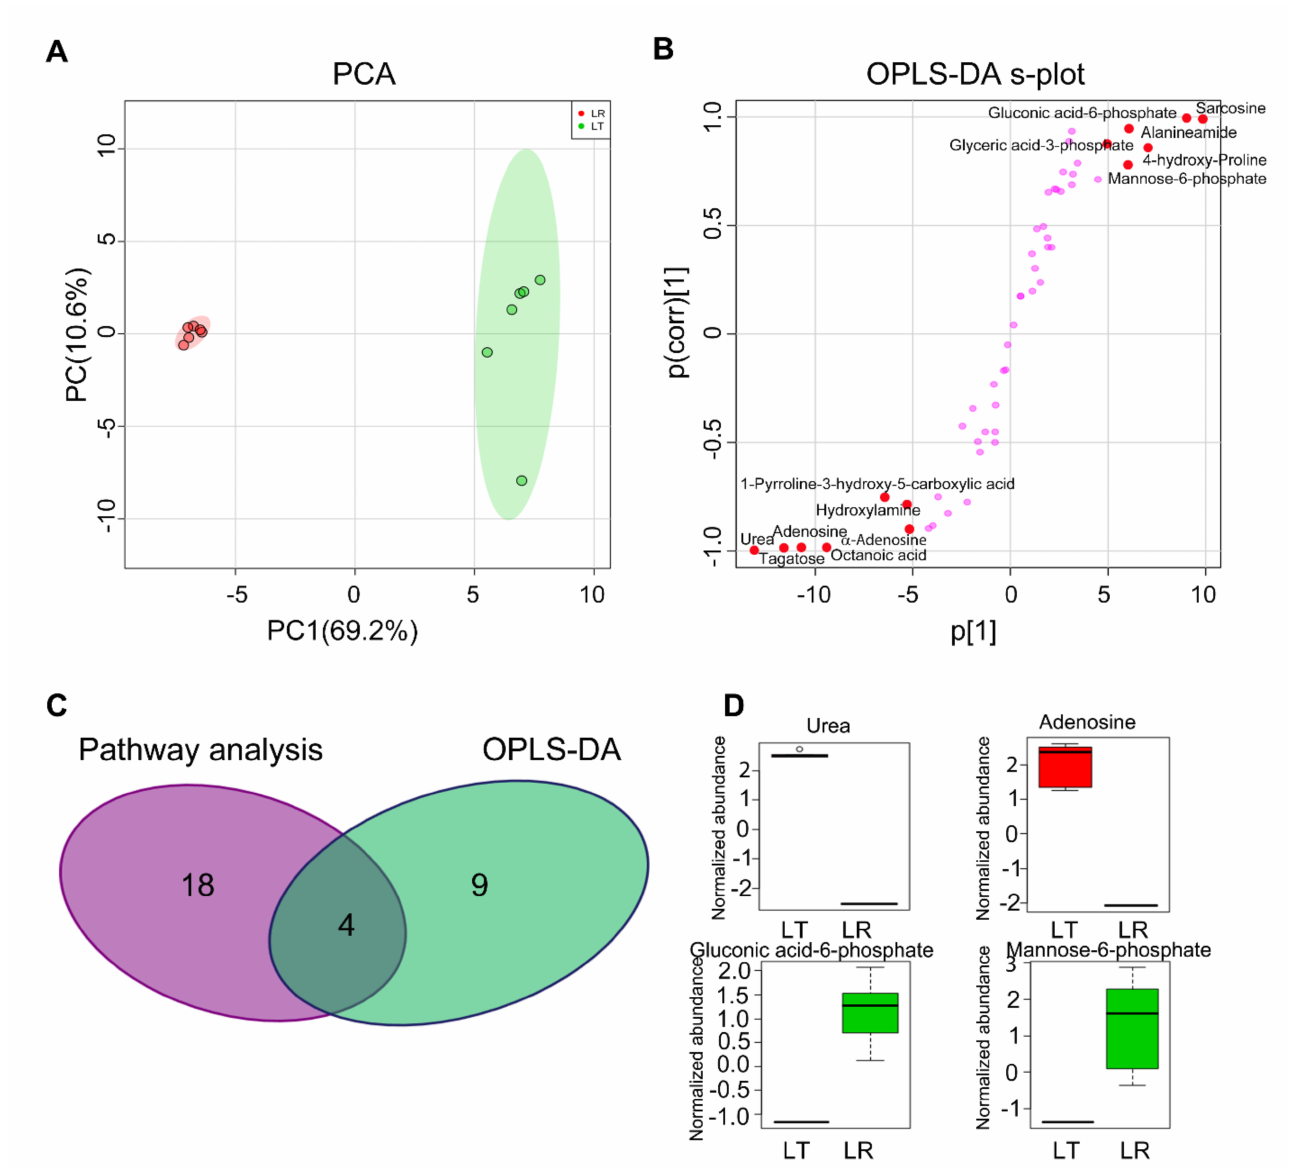
Figure 4. Identification of crucial metabolites. ( A ) PCA analysis of LT and LR groups according to the treatments set. Each dot represents a technological replicate analysis of samples in the plot. PC1 and PC2 used in this plot explain 79.8% of the total variance, which allows confident interpretation of the variation. PC1, principal component 1; PC2, principal component 2. ( B ) S-plot generated from OPLS- DA (R2X = 0.454, R2Y = 0.975, Q2 = 0.949). Predictive component p [1] and correlation p (corr) [1] differentiate LT from LR. Dots represent metabolites, and candidate biomarkers are highlighted in